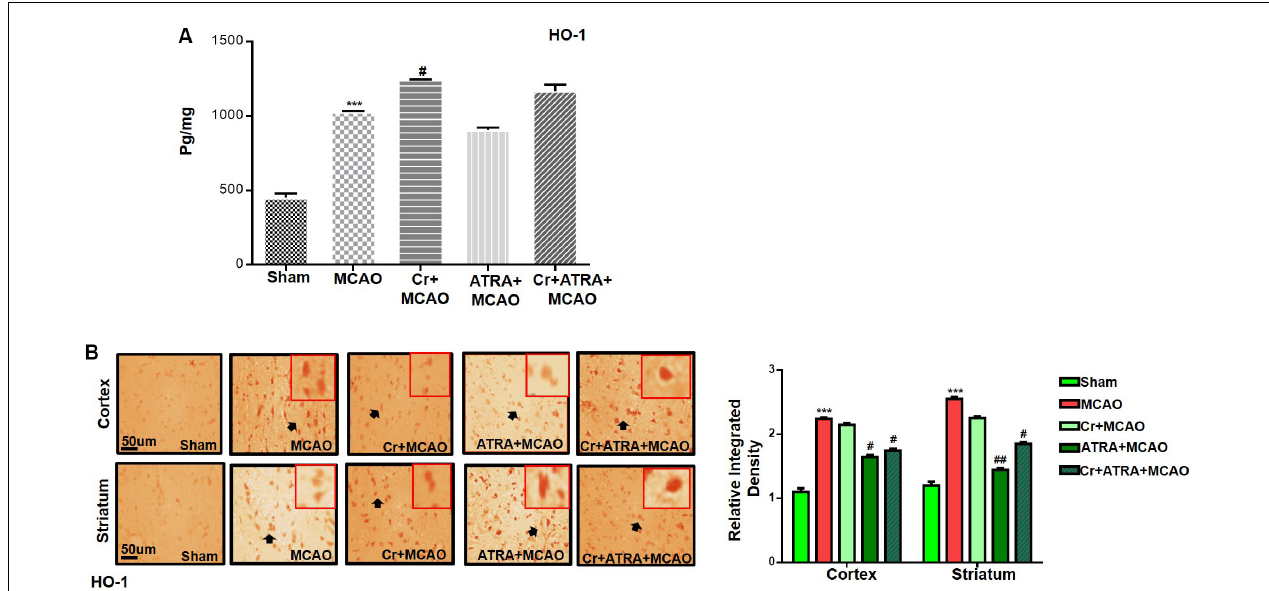
FIGURE 6 | Carveol (20 mg/kg) enhances the antioxidant capacity of the brain via the Nrf2 signaling pathway. (A) ELISA analysis of HO-1 in the cortex. The data were expressed as the mean ± SEM and analyzed by one-way ANOVA followed by post hoc Bonferroni multiple comparison test using GraphPad Prism 6 software. *** p < 0.001 shows difference relative to sham while # p < 0.05 shows significant difference relative to MCAO. (B) Immunohistochemistry results for HO-1 in cortex and striatum tissues of the brain. Scale bar 50 µ m, magnification 40 × ( n = 5/group). HO-1 exhibited nucleus localization in both tissues. Histograms show a comparatively higher expression of Nrf2 in various segments of the MCAO and CR groups. *** p < 0.001 shows significant difference relative to sham, while # p < 0.05 and ## p < 0.01 shows significant difference relative to MCAO group.